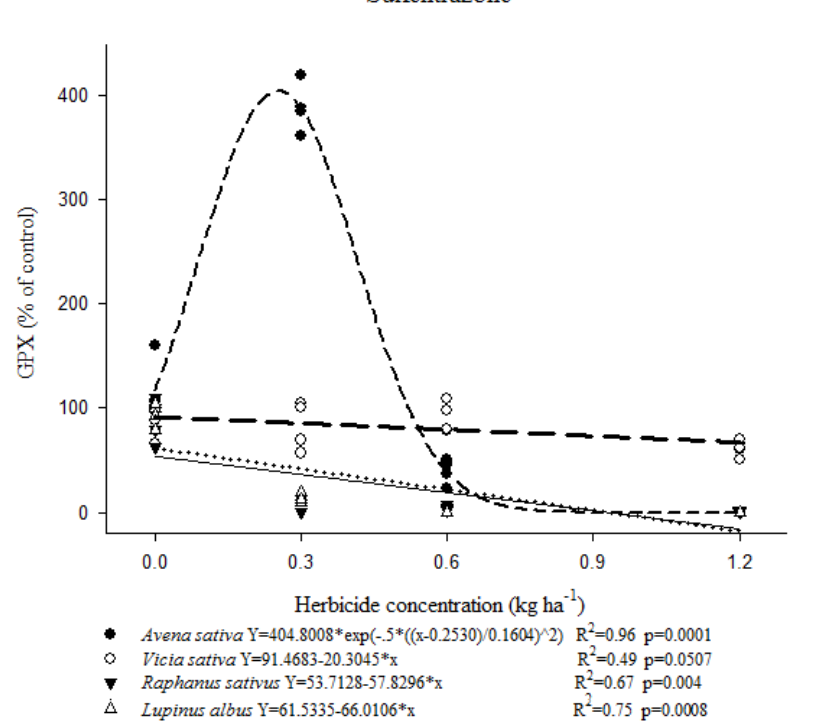
Figure 4 - Effect of sulfentrazone on Guaiacol peroxidase (GPX) activity in different crop